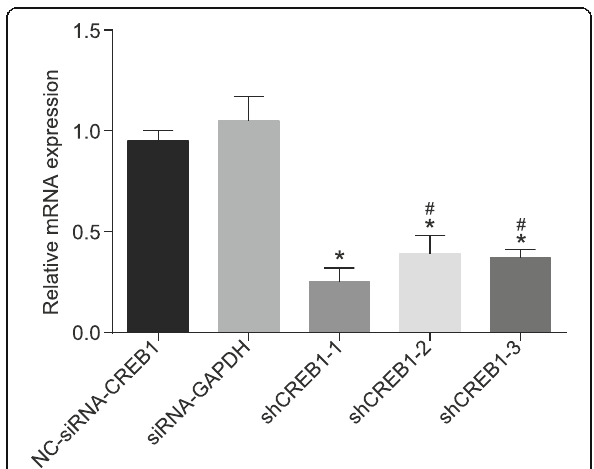
Fig. 1 The shCREB1 – 1 group with best silence efficiency is selected for the subsequent experiments, Notes: * , p < 0.05, compared with the NC-siRNA-CREB1 groups; #, p < 0.05, compared with the shCREB1 – 1 group; CREB1, cyclic adenosine monophosphate respon- sive element-binding protein 1; NC, negative